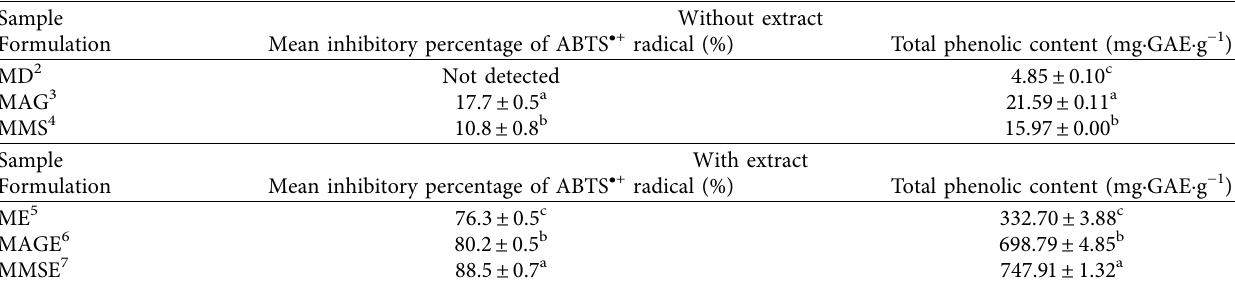
Table 6: Antioxidant properties and total phenolic content of the coated extract with different wall materials 1 . Sample Without extract Formulation